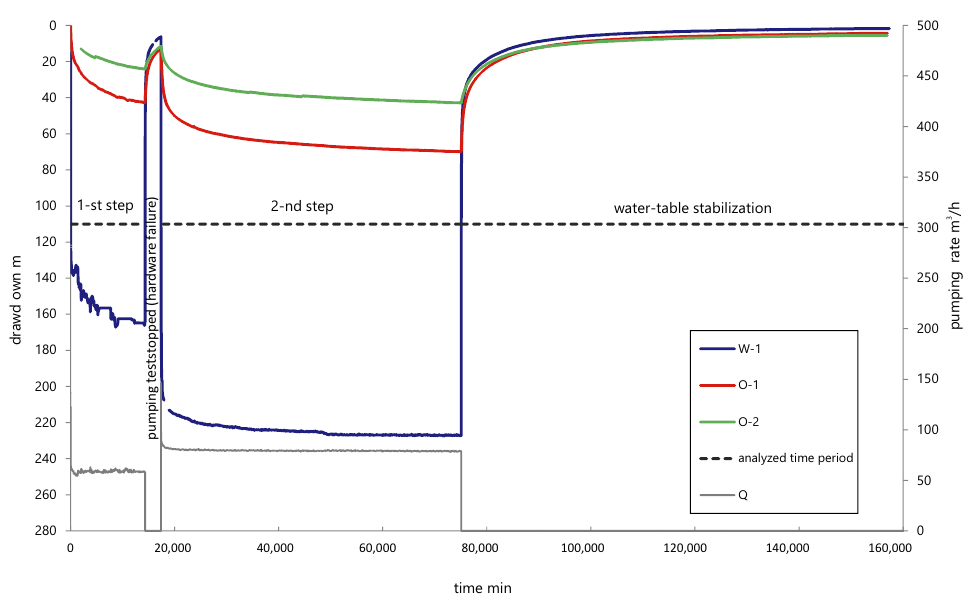
Figure 5. Pumping test